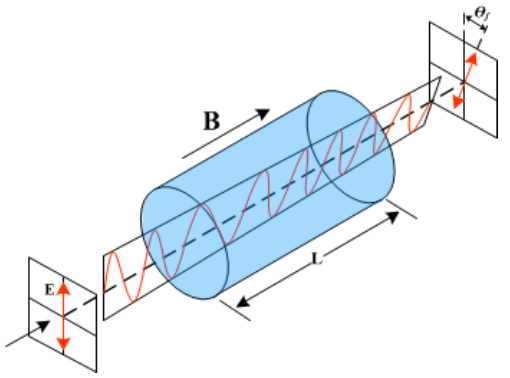
Figure 1. Faraday effect in linearly polarized